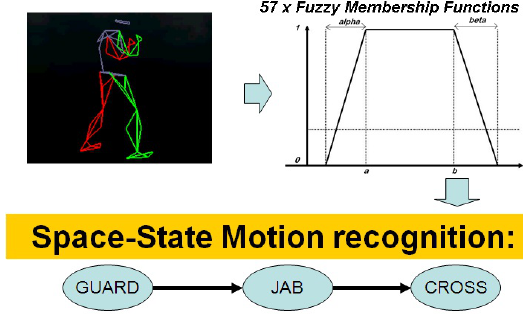
Fig. 1 3D motion data capture